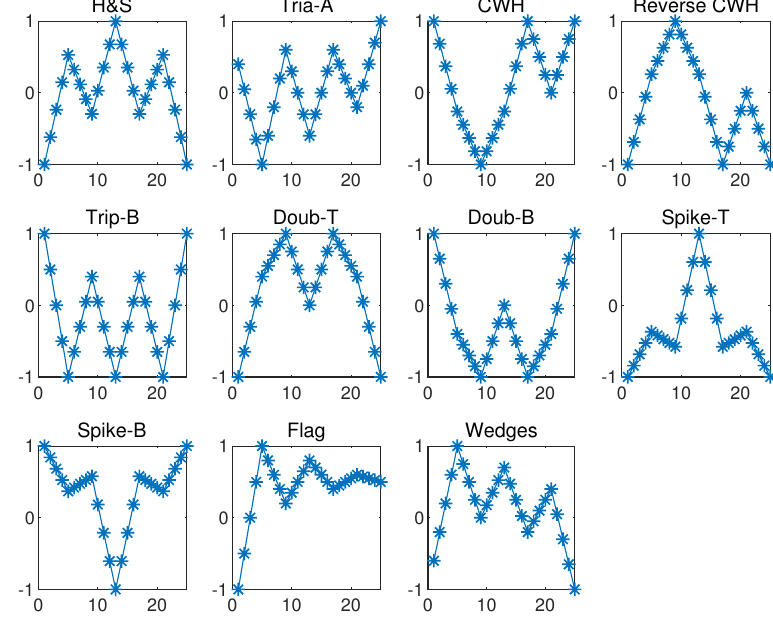
Figure A3. The representation of the Scaling